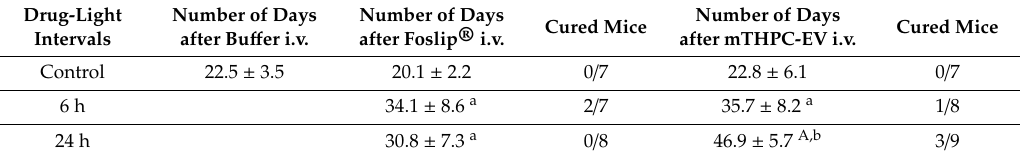
Table 2. Remission occurrence and number of days after treatment required to reach 10 times the initial tumor volume, excluding remission cases. Remission was defined as the absence of tumor regrowth at 90 days after treatment. a : p < 0.05, A : p < 0.01, statistically di ff erent from control; b : p < 0.01, statistically di ff erent between Foslip ® and mTHPC-EVs. Non-irradiated tumors were considered as the control group (drug, no light). n = 5–7 mice for control; n = 7–9 mice for photodynamic therapy (PDT) conditions.